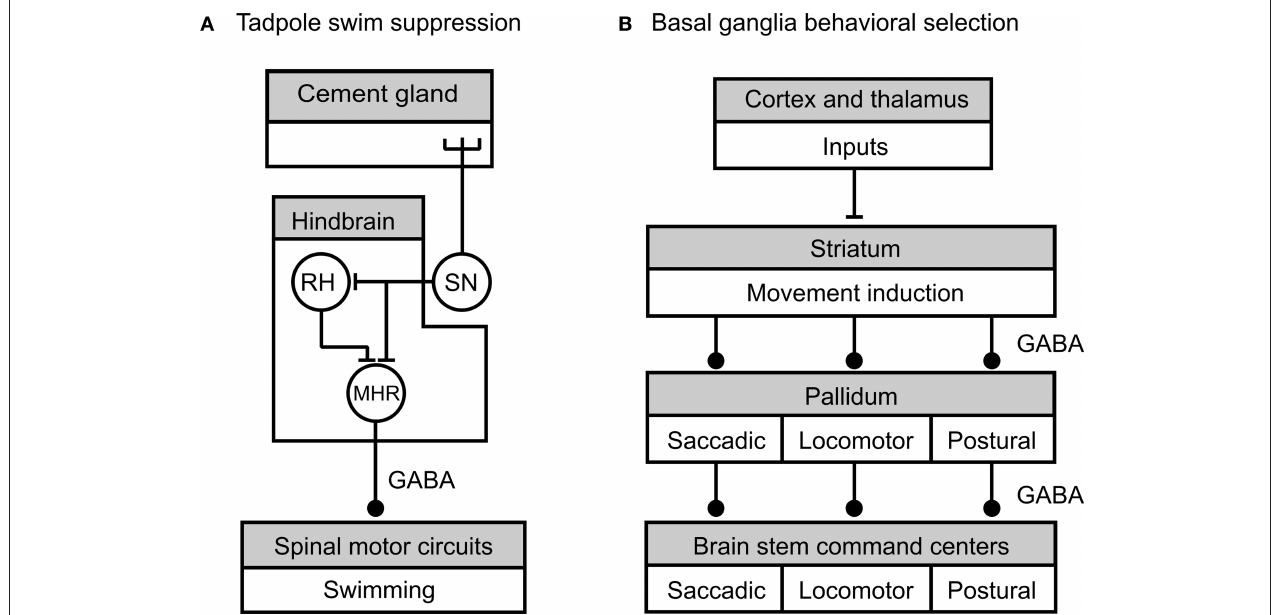
excitatory synaptic connections to the striatal input area of the basal ganglia that is involved in movement induction and selection. Striatal neurons activate brain stem command centers by inhibiting the firing of pallidal neurons. In the absence of striatal activity, pallidal neurons fire at high rates and provide tonic inhibition to brain stem command centers that are responsible for the activation of motor programs for saccadic eye movements, locomotion and posture. The striatum thus provides a disinhibitory mechanism for the generation of basic movements. Striatal and pallidal control pathways are functionally organized to allow the selective disinhibition of particular motor programs. This is indicated by the division of motor programs into boxed compartments with a corresponding segregation of the inhibitory connecting pathways. All the inhibitory connections in these circuits are GABAergic. A stick indicates an excitatory synaptic connection between neurons or nuclei, and a ball an inhibitory synaptic